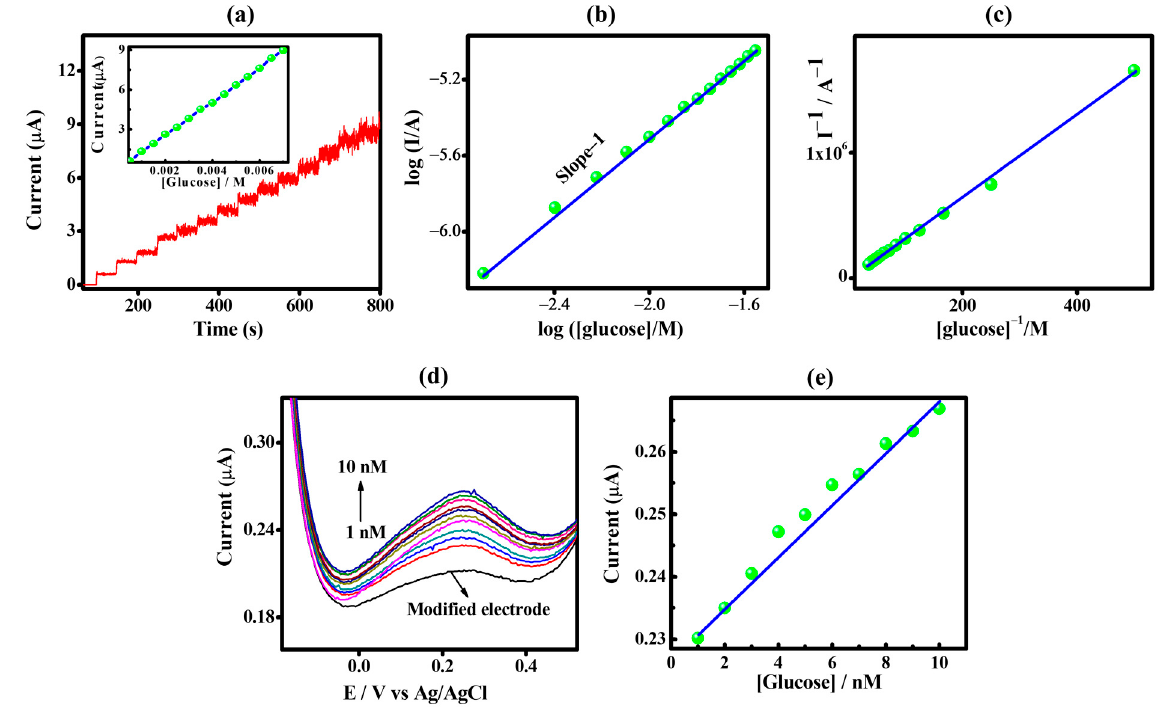
Figure 5. ( a ) Effect of different glucose concentration on CA behavior of ZnO–g–Ru–C 3 N 4 measured at 0.26 V in PBS pH 7.4. Concentration range 2 to 26 mM and inset glucose concentration versus current plot. ( b ) log concentration versus log current. ( c ) Line weaver Burk plot (1/current vs. 1/[glucose]). ( d ) Effect of glucose concentration on DPV behavior of ZnO–g–Ru–C 3 N 4 measured in PBS pH 7.4. Concentration range 1 to 10 nM ( d ) for ZnO–g–Ru–C 3 N 4 modified electrode and ( e ) glucose concentration versus current plot.